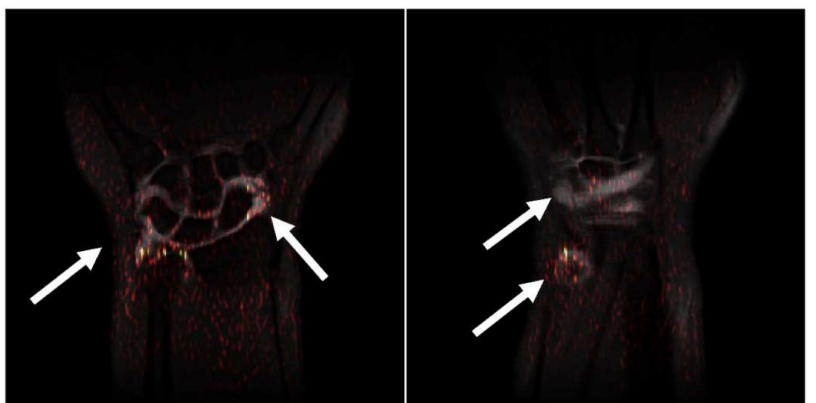
Figure 4. The activation heatmaps overlaid on the original MRI scans. The white arrows indicate the overlapping area of the contrast media and